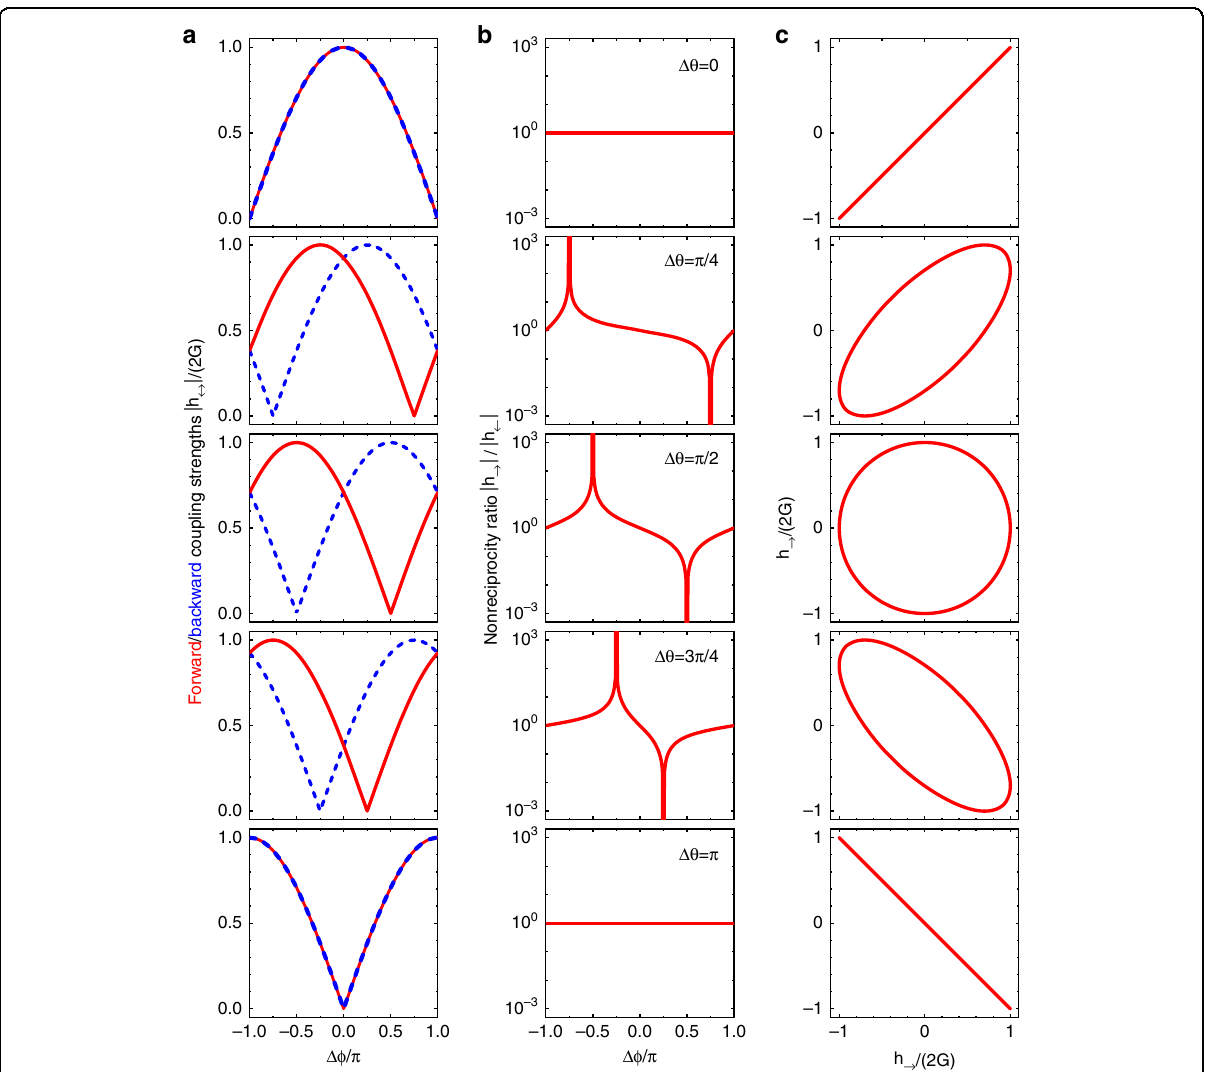
Fig. 2 Forward and backward coupling strengths. a Amplitudes of the forward coupling j h ! j (red solid curve) and the backward coupling j h j (blue dashed curve) as functions of Δ ϕ . b Nonreciprocity ratio j h ! j = j h j vs. Δ ϕ . c Parametric plots of h ! and h as functions of Δ ϕ . The parameters are Δ θ ¼ 0 ( fi rst row), Δ θ ¼ π = 4 (second row), Δ θ ¼ π = 2 (third row), Δ θ ¼ 3 π = 4 (fourth row), and Δ θ ¼ π ( fi fth